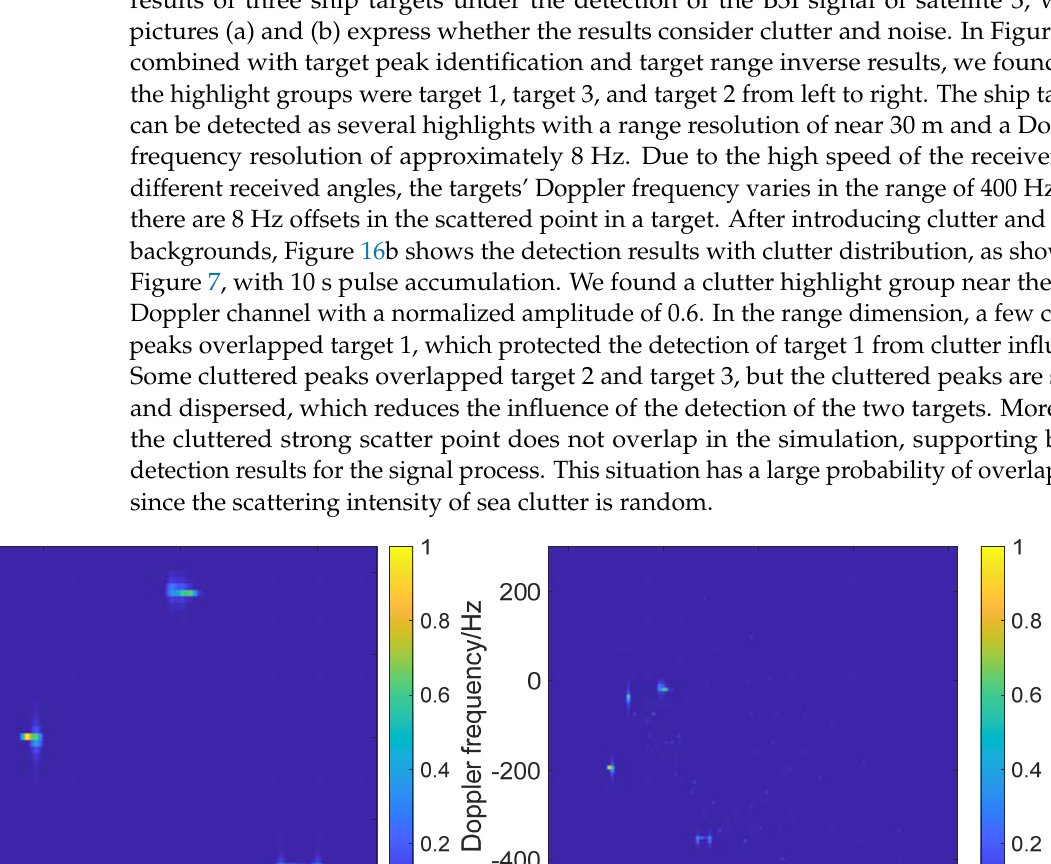
Figure 15. Range inversion results of 3 ship targets under the detection of BDS satellite 3 with target estimation information by range inversion method 2: ( a ) ship 1; ( b ) ship 2; ( c ) ship 3.